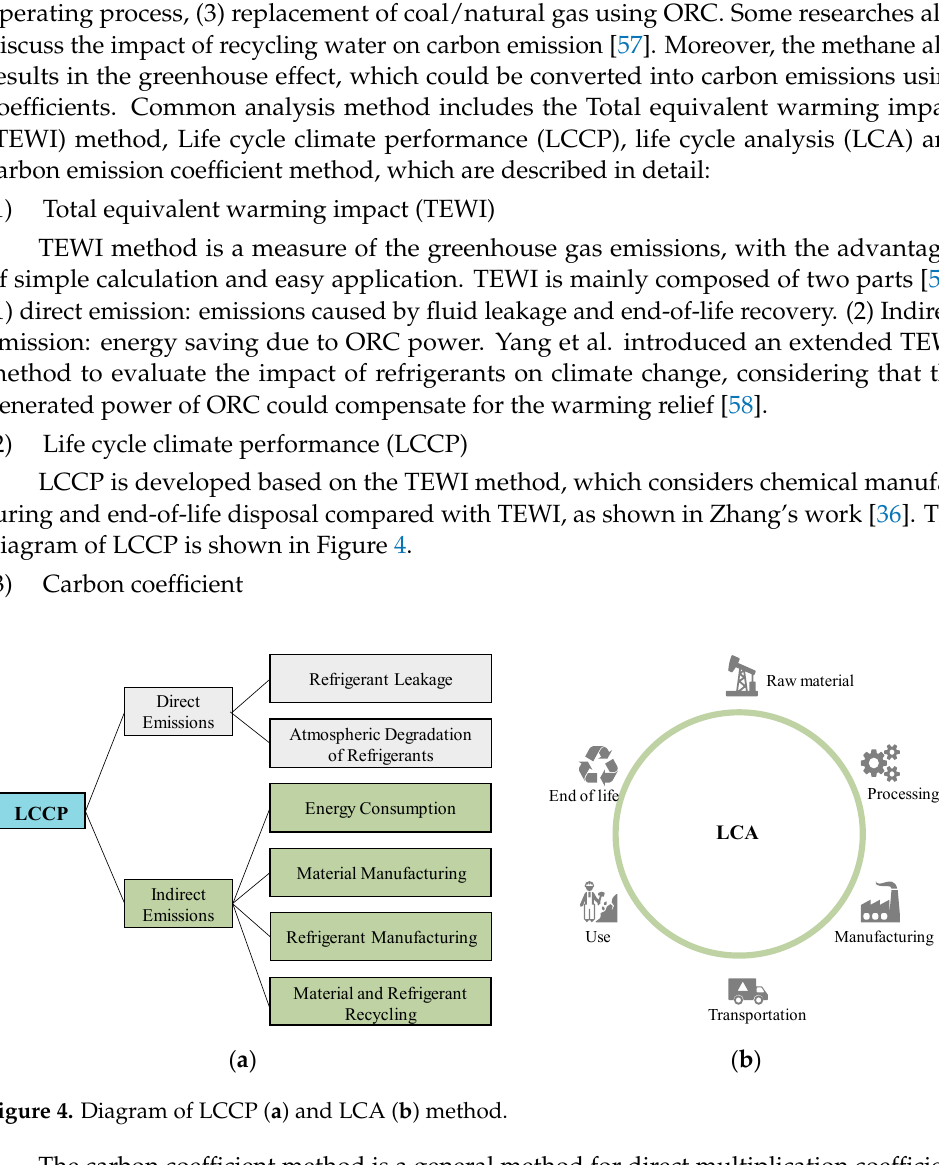
Table 2. Typical references involving carbon dioxide emission.